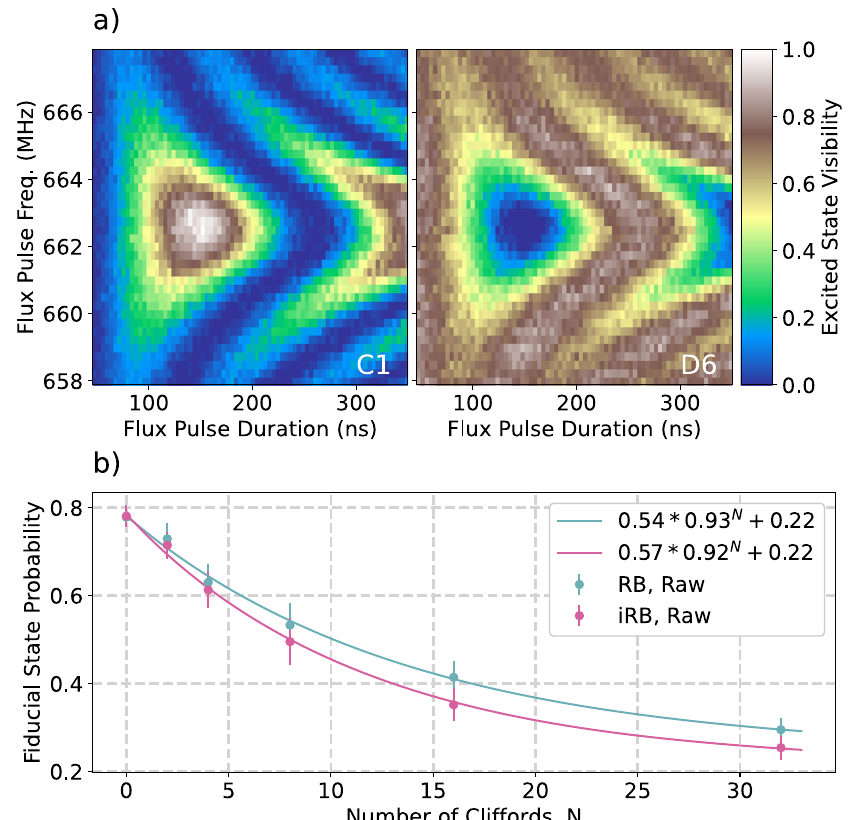
Fig. 3 Two-qubit gate data for an iSWAP gate on the C1-D6 pair. a Excited state visibility as a function of AC fl ux modulation frequency and pulse duration. Full population transfer occurs at agate modulation frequency of 662.5 MHz and 152 ns. b RB and iRB benchmarking data. Fitting the exponential decay for thestandard and interleaved benchmark gives an RB fi delity of 95.8% ± 0.2% and an iRB fi delity of 99.1% ± 0.5%. Error bars represent the 95% con fi dence bounds on the fi tted fi delity for each measurement.